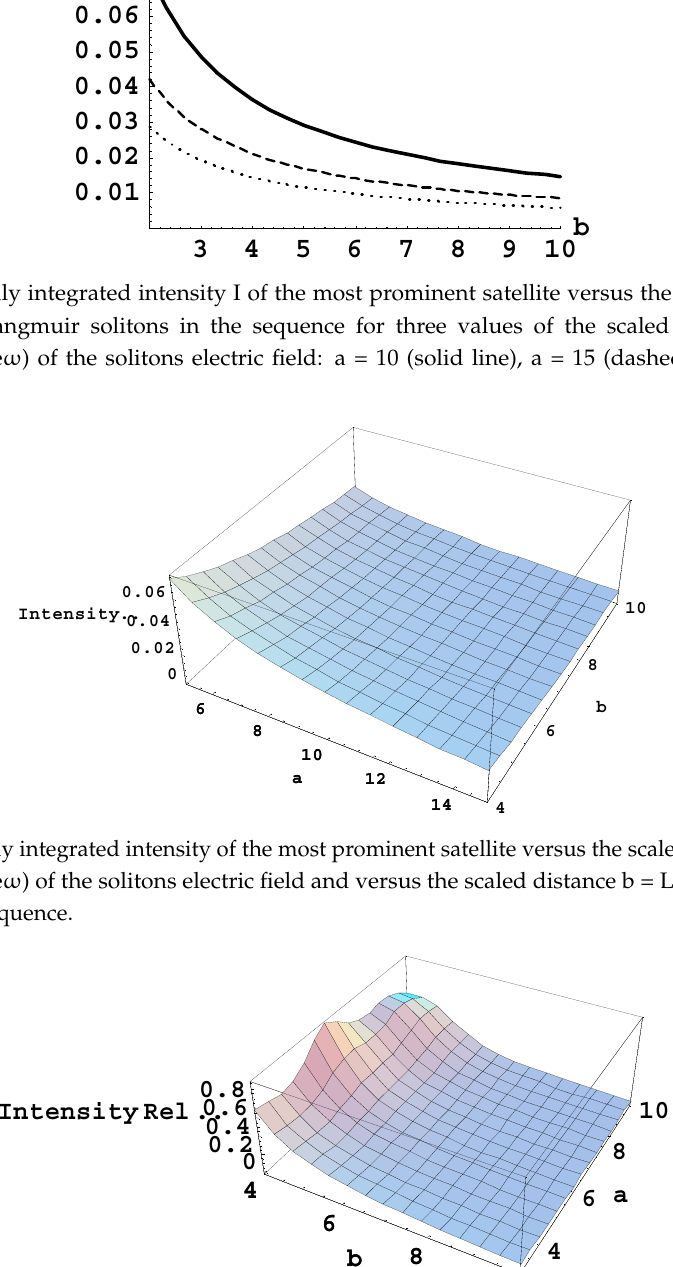
Figure 3. The ratio f[p max (a), a, b]/ f[0, a, b] of the spatially integrated intensity of the most prominent satellite to the spatially integrated intensity of the “zeroth” satellite versus the scaled amplitude a = 3¯ h X k E 0 /(2Z r m e e ω ) of the solitons electric field and versus the scaled distance b = L/ λ of Langmuir solitons in the